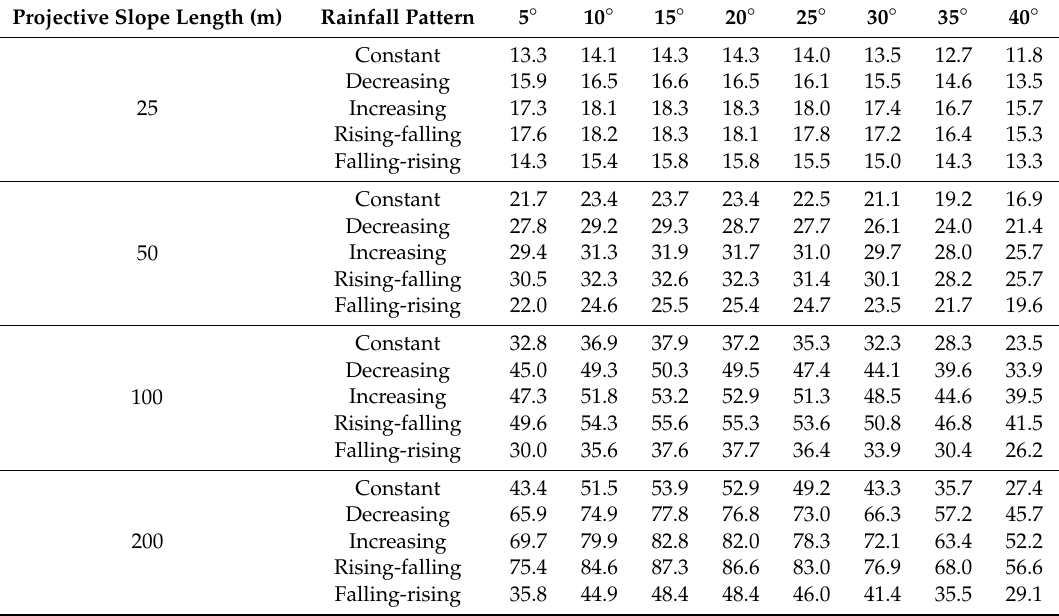
Table 2. Simulated results of total runo ff (m 3 ) at di ff erent projective slope lengths. Projective Slope Length